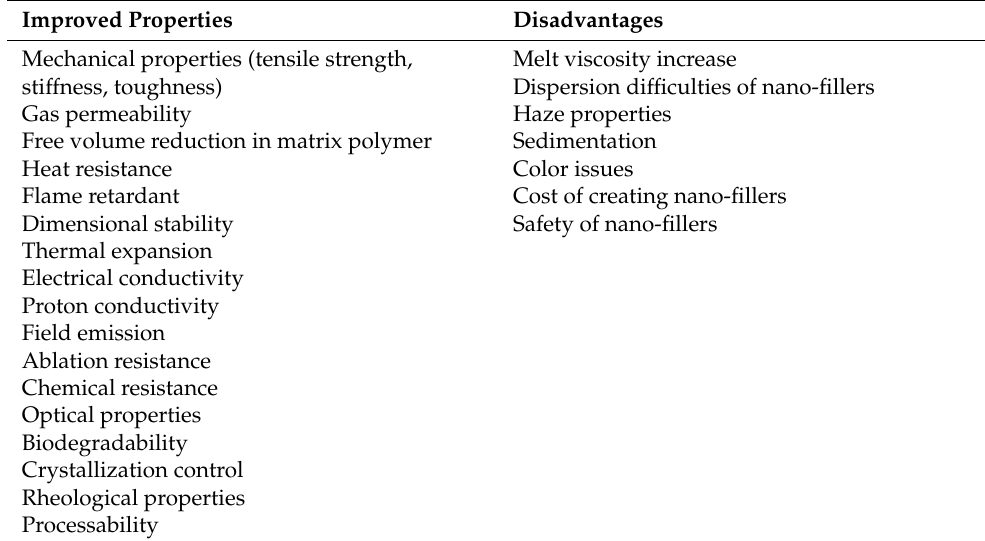
Table 1. Advantages/disadvantages of polymer